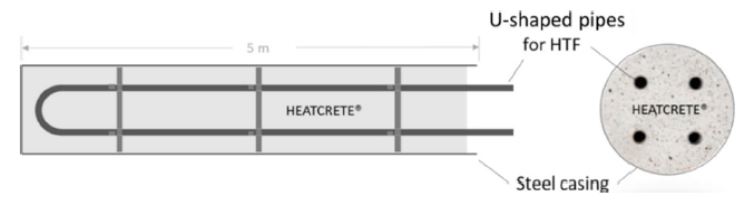
Figure 2. Concrete thermal element design for the HEATCRETE vp1 concept [20] .